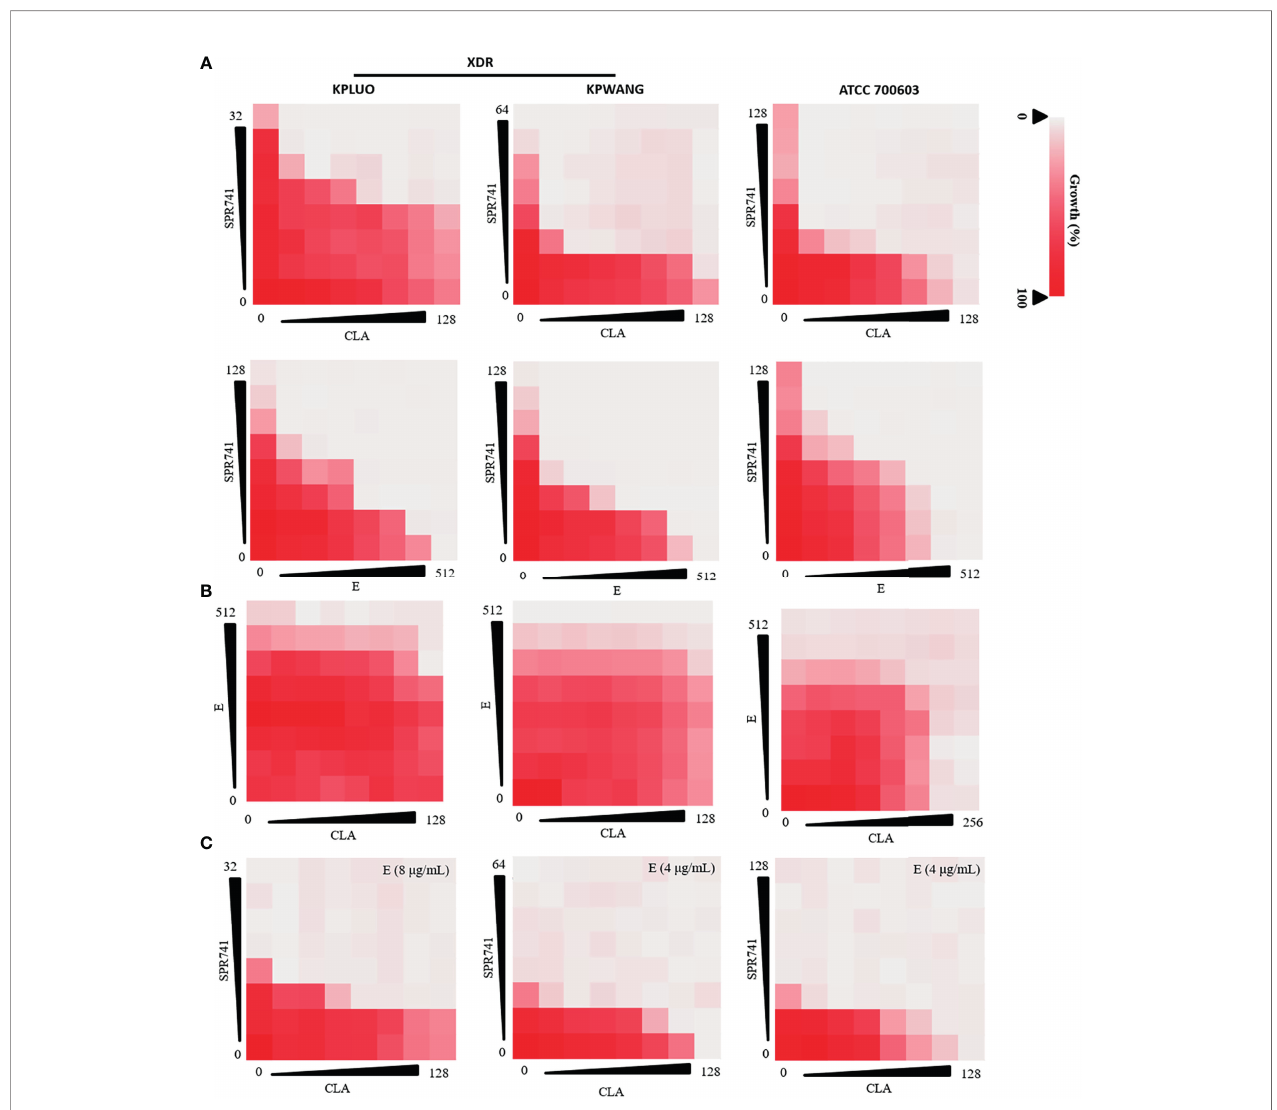
FIGURE 2 | Combination anti-microbial activities of SPR741, CLA, and E against XDR and type strain of K. pneumoniae . Double antibiotic combination of SPR741 with CLA or E (A) , combination of CLA and E (B) , and triple combination of SPR741 with CLA and different concentrations of E (C) against XDR K. pneumoniae KPLUO, KPWANG, and type strain ATCC 700603. Experiment was repeated three